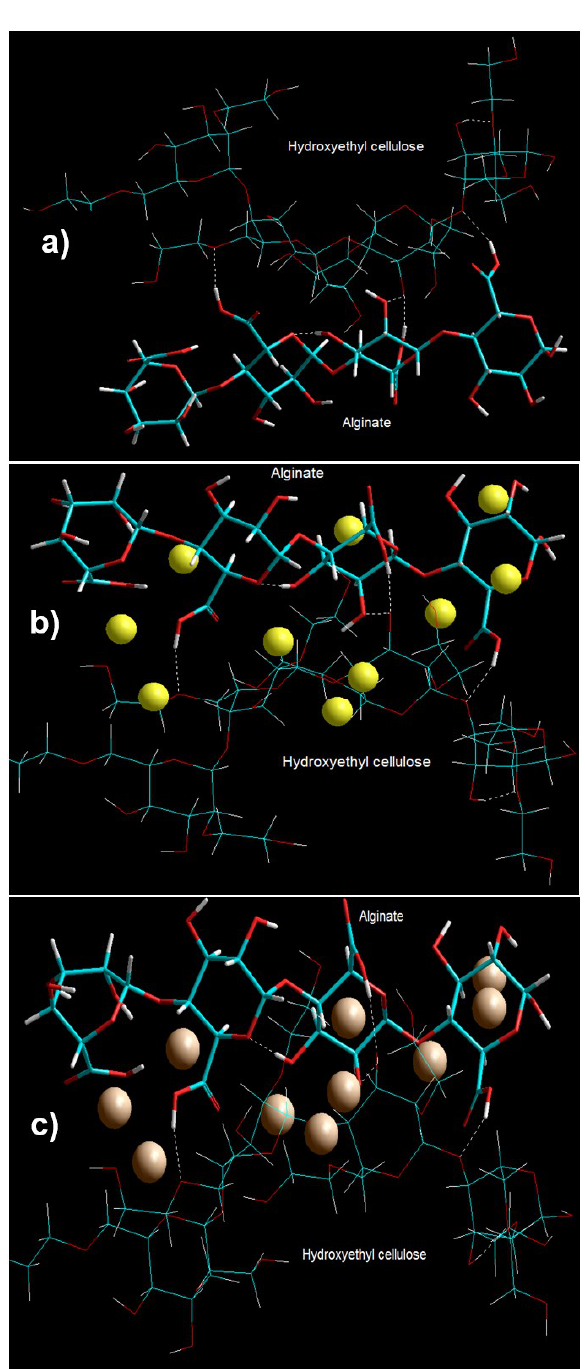
Figure 5. Visualization of geometrical preference of ( a ) Hydroxyethyl cellulose in complexation with alginate; ( b ) oligosaccharide–Ca 2+ complex, and ( c ) oligosaccharide–Ba 2+ complex derived after molecular mechanics simulations. Color codes: C (cyan), O (red), N (blue), Ca (yellow), Ba (brown), and H (white).